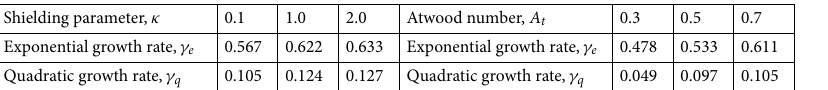
Table 1. The exponential growth rate γ e and quadratic growth rate γ q of single-mode RTI (spike) at different shielding parameter κ and Atwood number A t